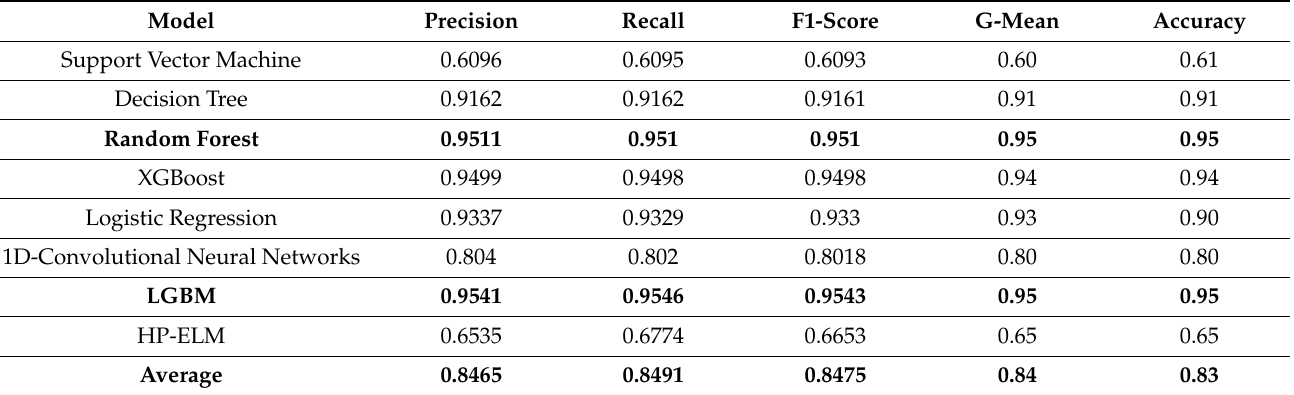
Table 3. Classification Performance by Machine Learning